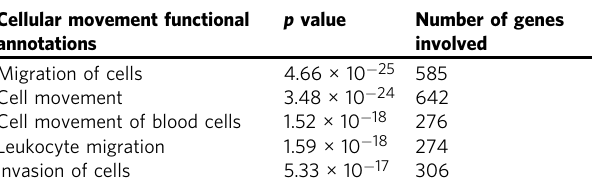
Table 2 Top- fi ve ranked IPA-annotations associated to ‘ cellular movement ’